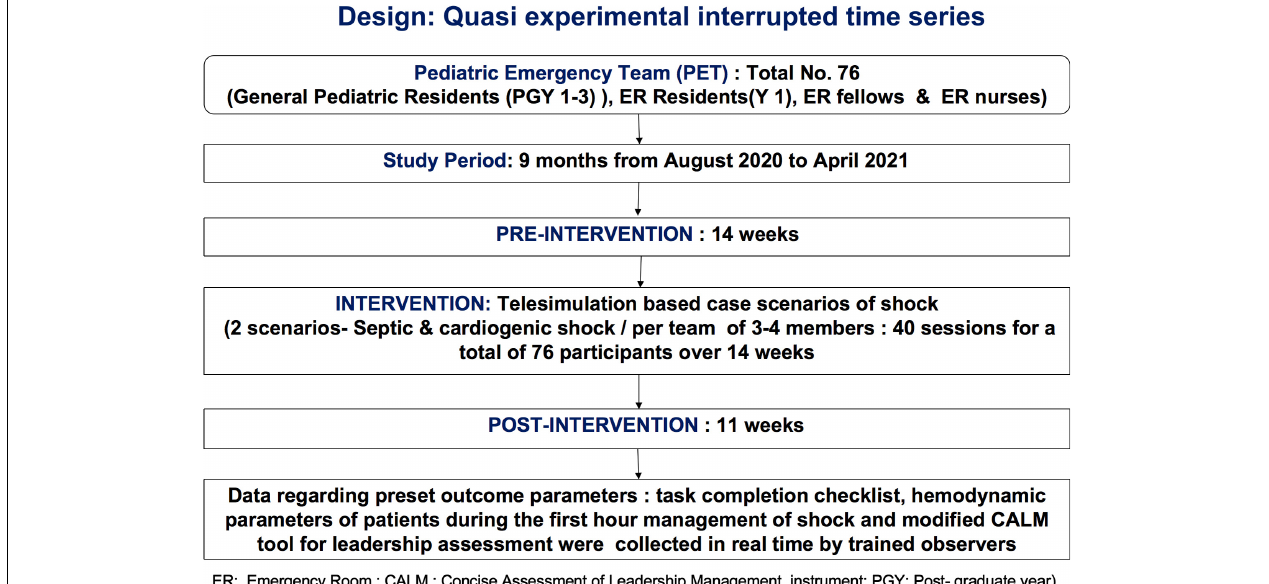
FIGURE 4 | Approach and design of the telesimulation study in the emergency